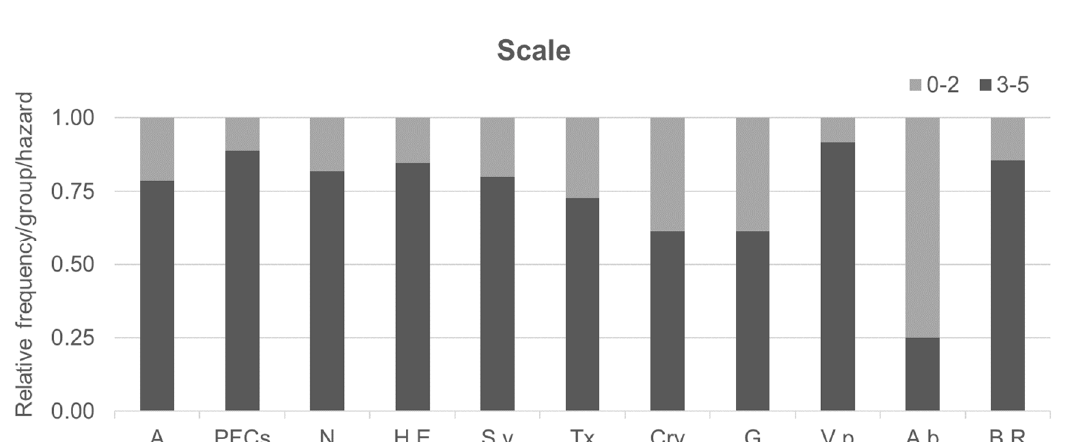
Figure 3. Results of the preliminary evaluation of emerging hazards by experts. A: Antimicrobials, PFCs: Perfluorinated compounds, N: Nanoparticles, HE: hepatitis E, Sv: sapovirus, Tx: tetrodotoxin, Cry: Cryptosporidium , G: Giardia , Vp: Vibrio parahaemolyticus , Ab: Arcobacter butzleri , BR: bacterial resistance.